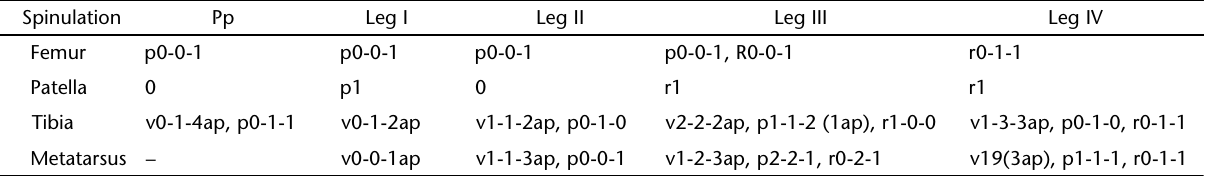
Table IV. Vitalius nondescriptus comb. nov. Female MZSP 465351 from Ouro Preto, state of Minas Gerais, Brazil. Spinulation of right legs and palpal segments.